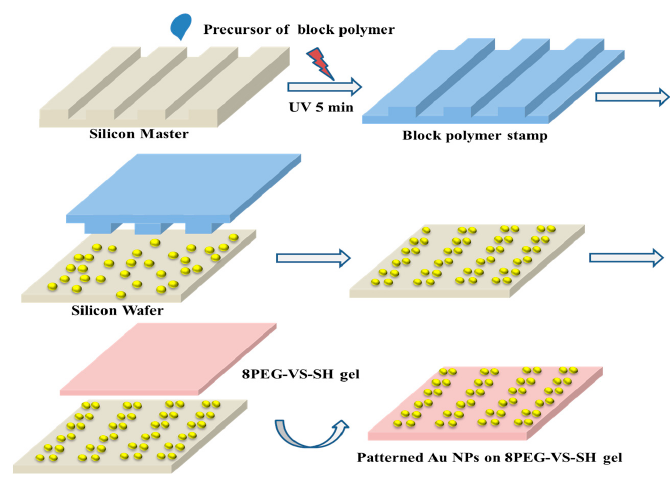
Figure 5 . Schematic diagram of patterning Au NPs on the surface of 8PEG-VS-SH hydrogels in the form of micrometer stripes.